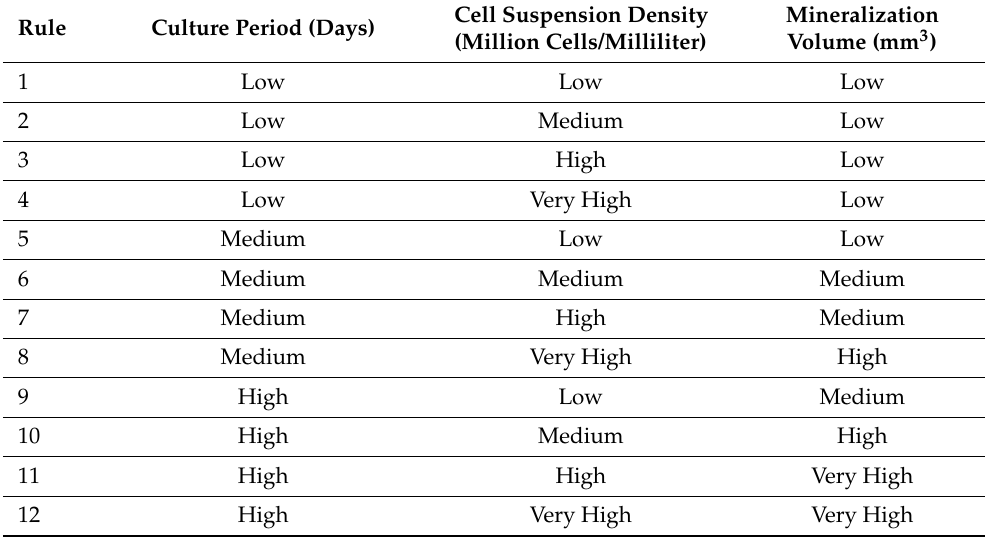
Table 3. Type-1 and Type-2 Fuzzy system